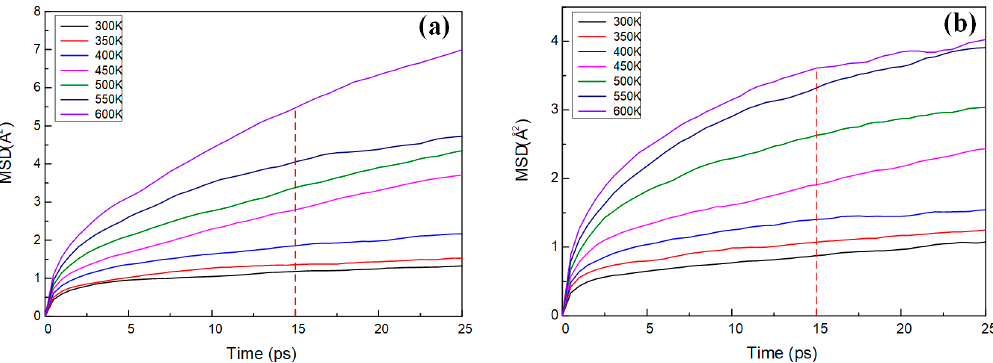
Figure 9. The MSD-time curves of epoxy resins. ( a ) DGEBA-MTHPA; ( b ) DGEBA-NA.